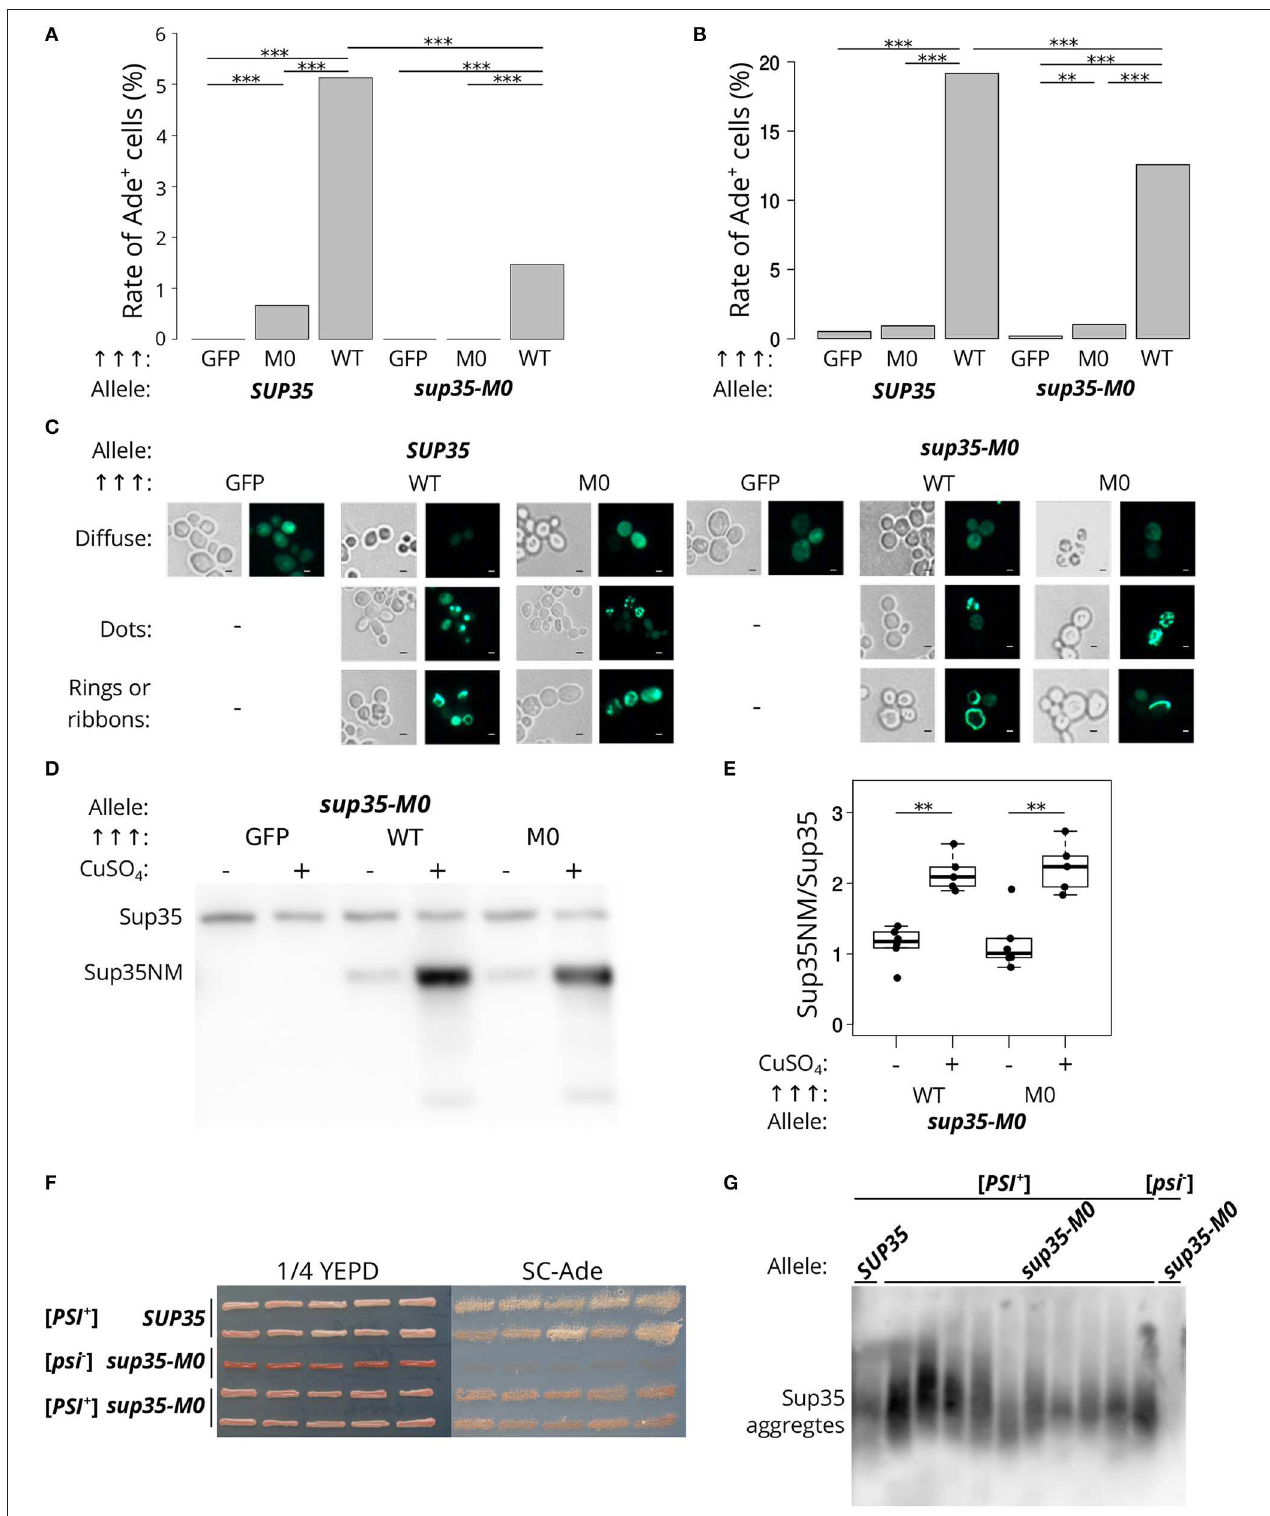
FIGURE 4 | sup35-M0 can induce and propagate [ PSI + ] prion but with low efficiency. (A) Frequencies of [ PSI + ] induction in the [ psi – ][ PIN + ] 7A-D832 (A) and 12-D1682 (B) cells upon overexpression of SUP35NM-GFP (WT) or sup35NM-M0-GFP (M0) in the presence of wild-type or mutant allele of SUP35 . Overproduction of